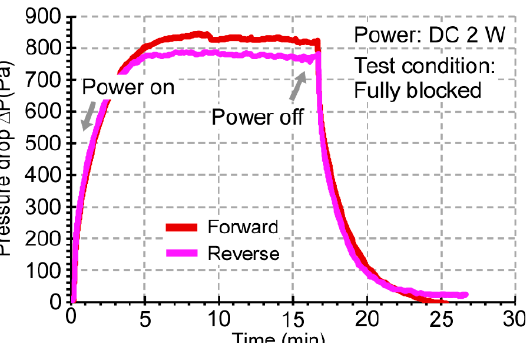
Figure 10. Transient profile of blocking pressure between the two flow ports of the KP with MCE membranes in forward and reverse pumping at 2 W applied power. The performance was stabilized in ≈ 5 min in both cases.